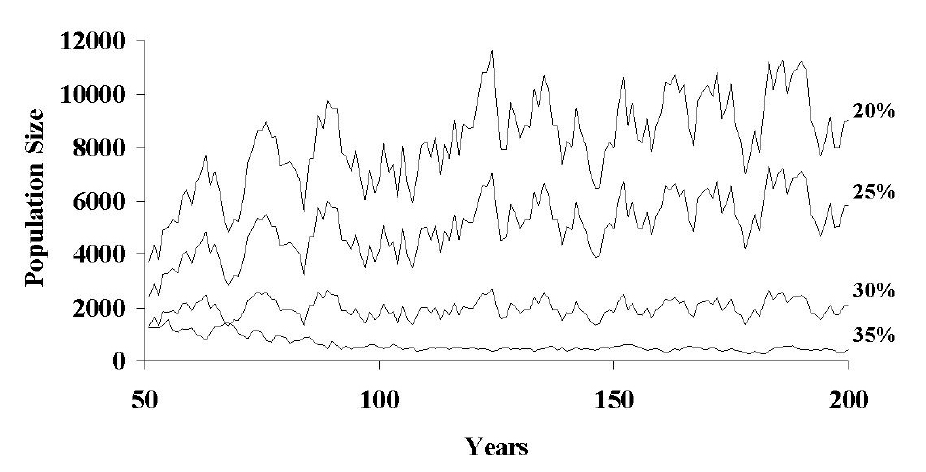
FIGURE 1 . Simulated population responses to varied mortality rates on gulf sturgeon between 35- and 150-cm total length, using an age-structured model. Populations were simulated for 200 years, dropping the initial 50 years to ensure that changes to input parameters were the only influence in simulation outcomes. Variables other than mortality were held constant or within set